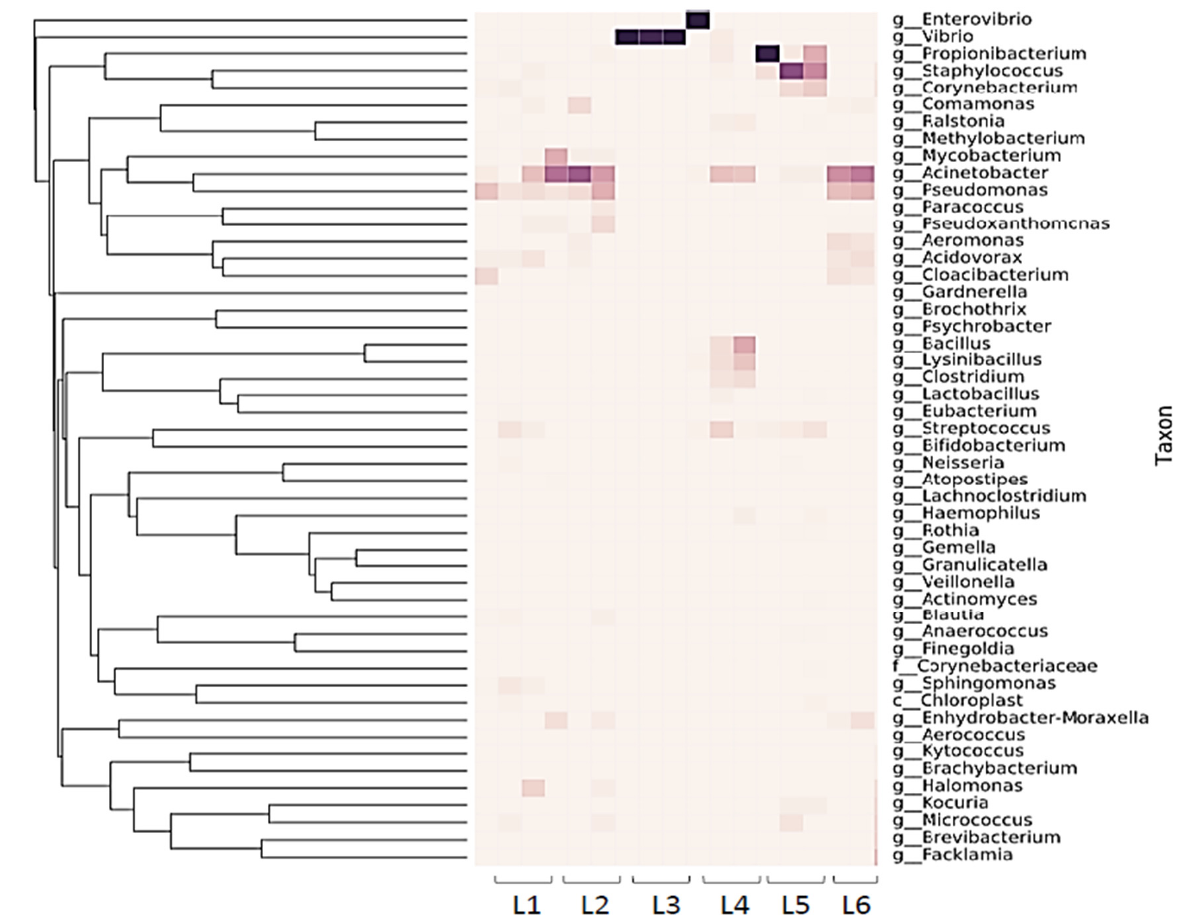
Figure 1. 16S rRNA sample heatmap showing diversity of 16S rRNA reads from sentinel washcloths laundered in 6 public laundromats (one washcloth per washing machine, with the laundromats designated as L1–L6).